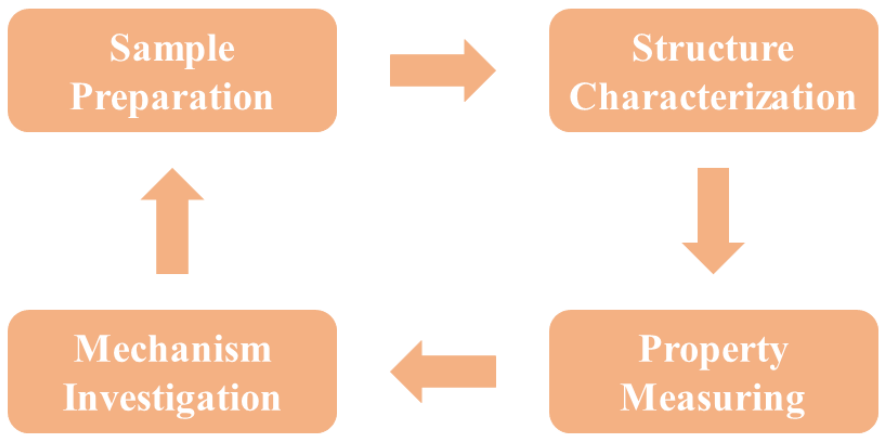
Figure 2. The program of research